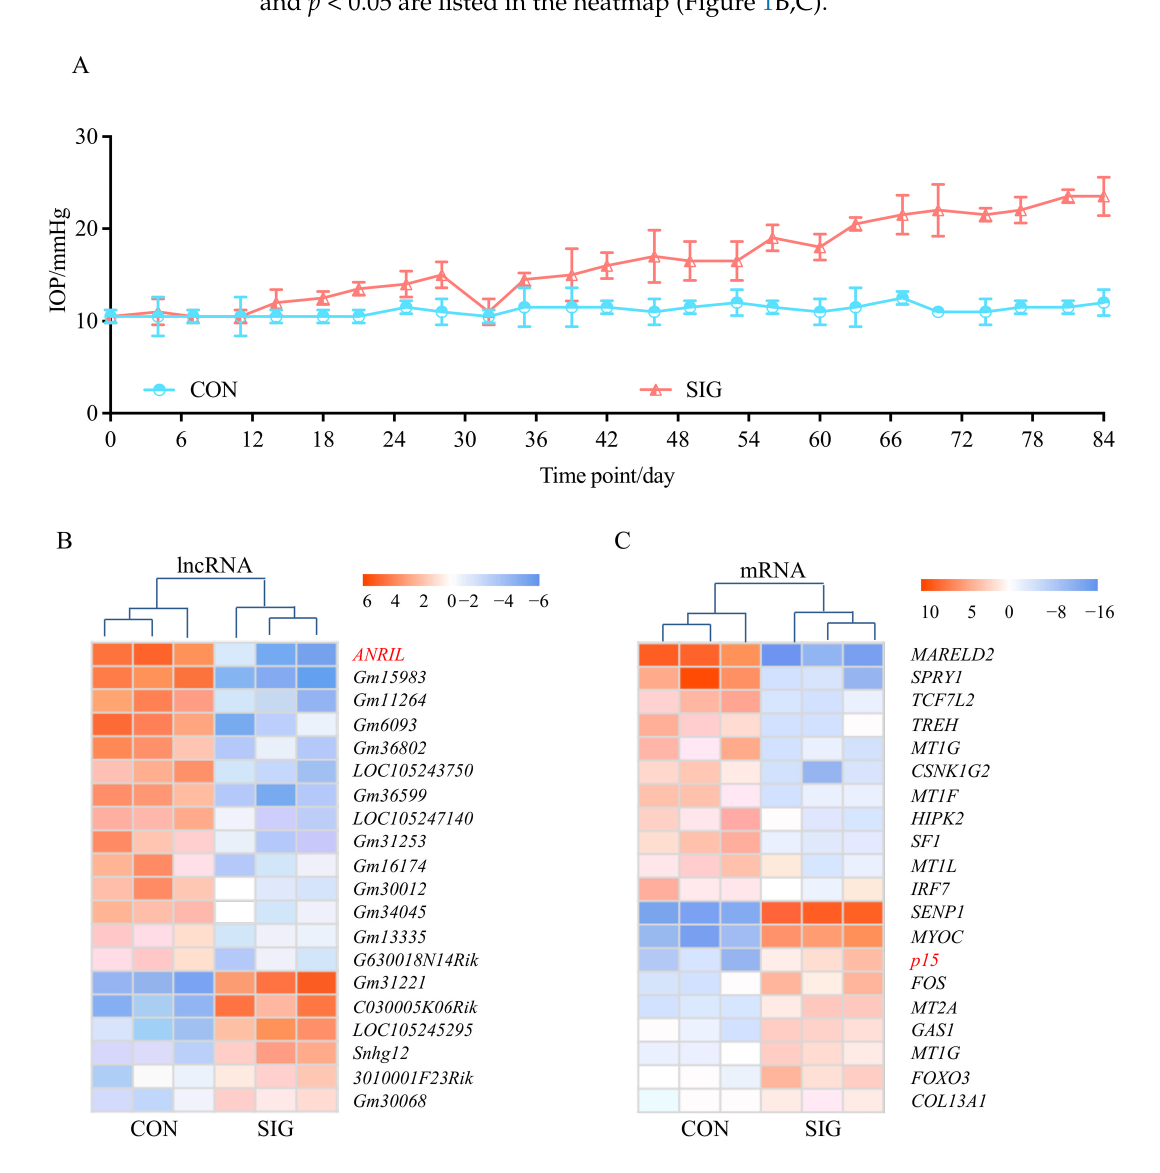
Figure 1. Transcriptome landscape in SIG mice. C57BL/6J mice were given topical 0.1% DEX or sterile PBS eye drops, 3 times daily for 12 weeks. IOP was measured in both eyes of control mice and SIG mice every three days ( A ). Only eyes with increased IOP (>21 mmHg) were recruited in the SIG group for the following microarray screening. TM tissues were isolated from SIG mice and normal controls as stated in the Methods. The dysregulated lncRNAs ( B ) and mRNAs ( C ) with a fold change >4 and p < 0.05 are listed in the heatmap. Notes: n = 3 per group; CON = control; SIG = steroid-induced glaucoma; IOP = intraocular